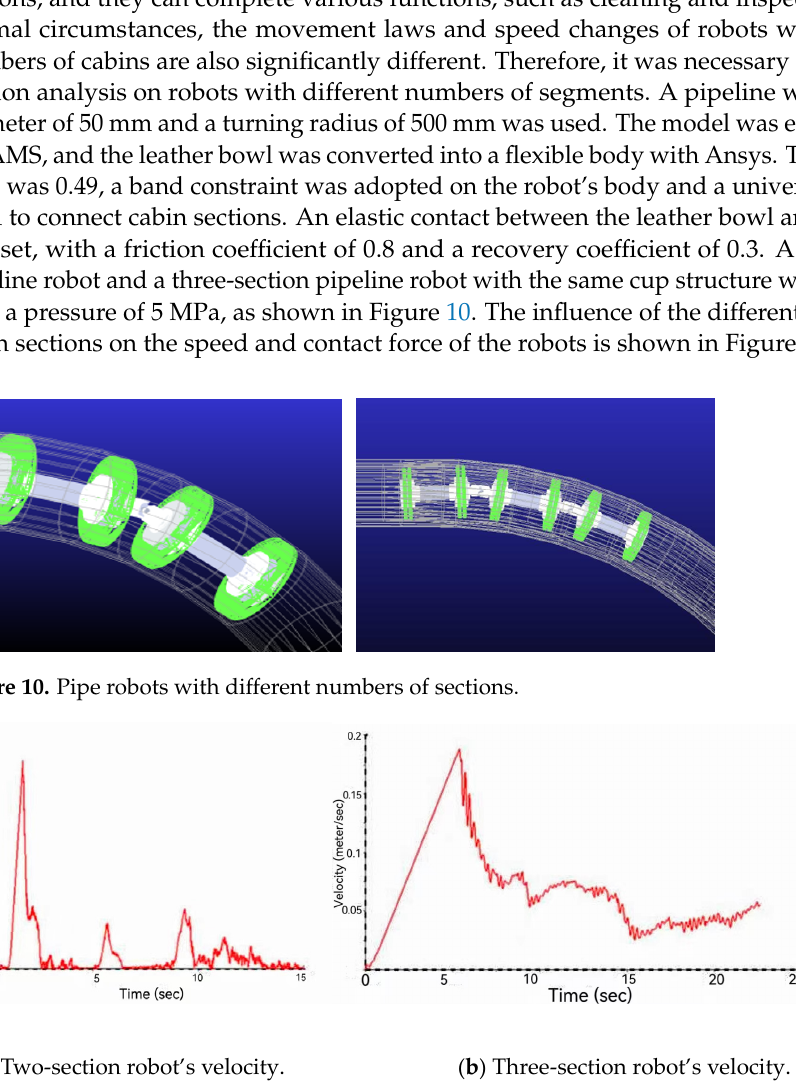
8 of 26 Figure 9. Average stress of leather bowl under di ff erent pressures.